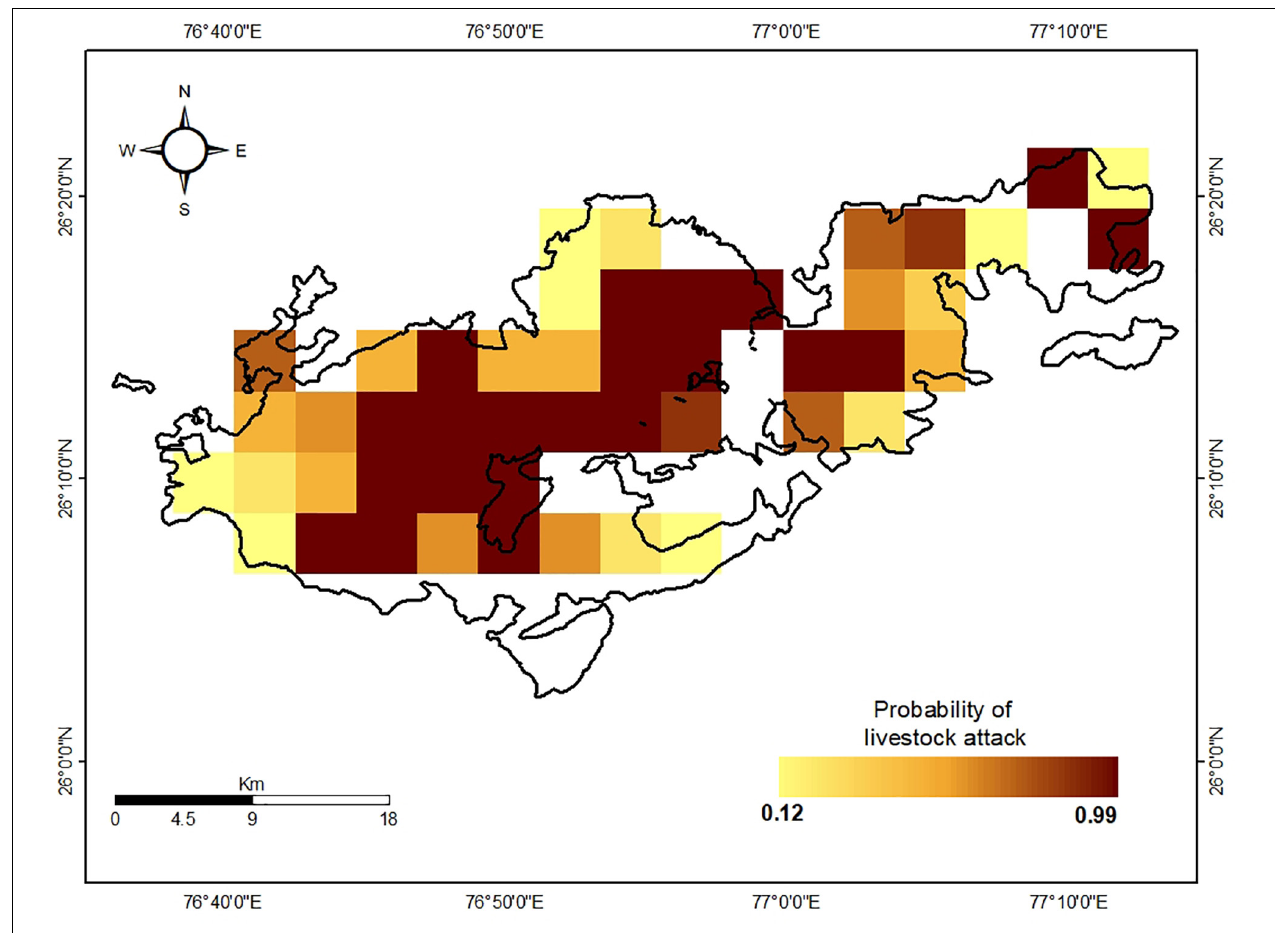
FIGURE 2 | Map showing estimated probability of livestock attack by wolves based on interview surveys across the Kailadevi Wildlife Sanctuary, Rajasthan,